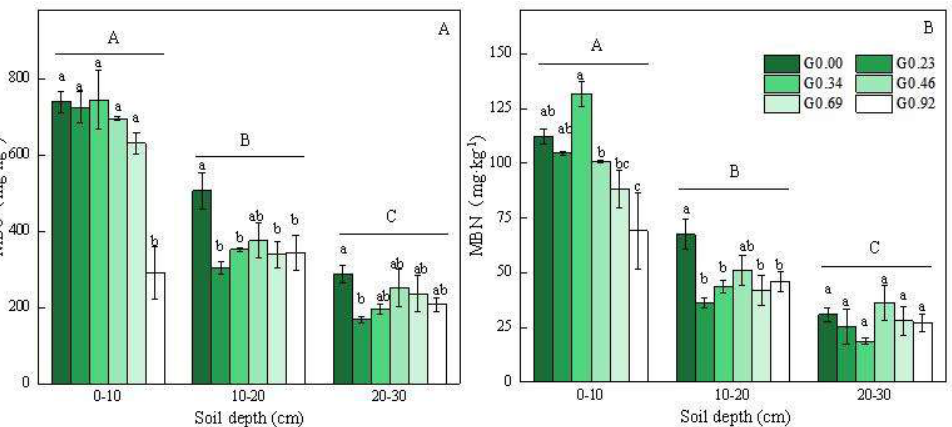
Figure 2. Microbial carbon (MBC) and nitrogen (MBN) contents in August 2018 under different grazing intensities. Lowercase letters represent significant differences between different grazing in- tensities ( p < 0.05); Capital letters represent significant differences between different soil depth ( p <0.05) .